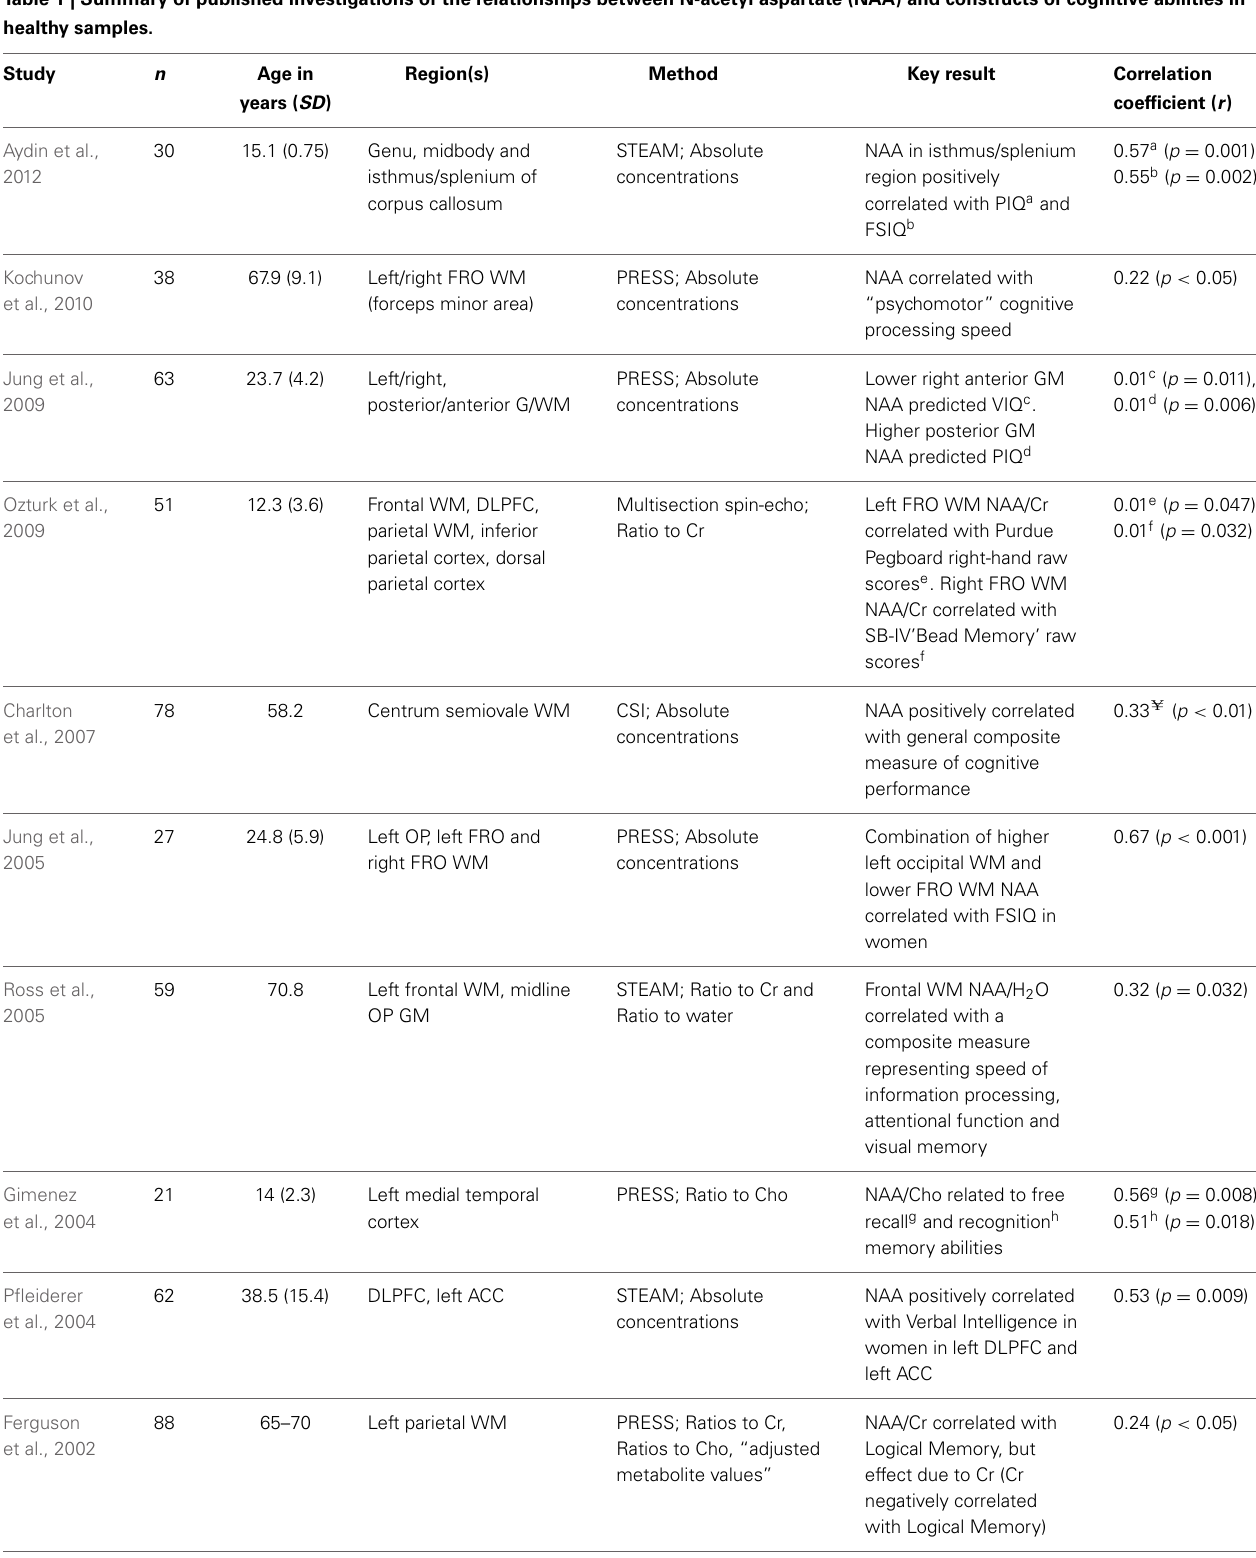
Table 1 | Summary of published investigations of the relationships between N-acetyl aspartate (NAA) and constructs of cognitive abilities in healthy